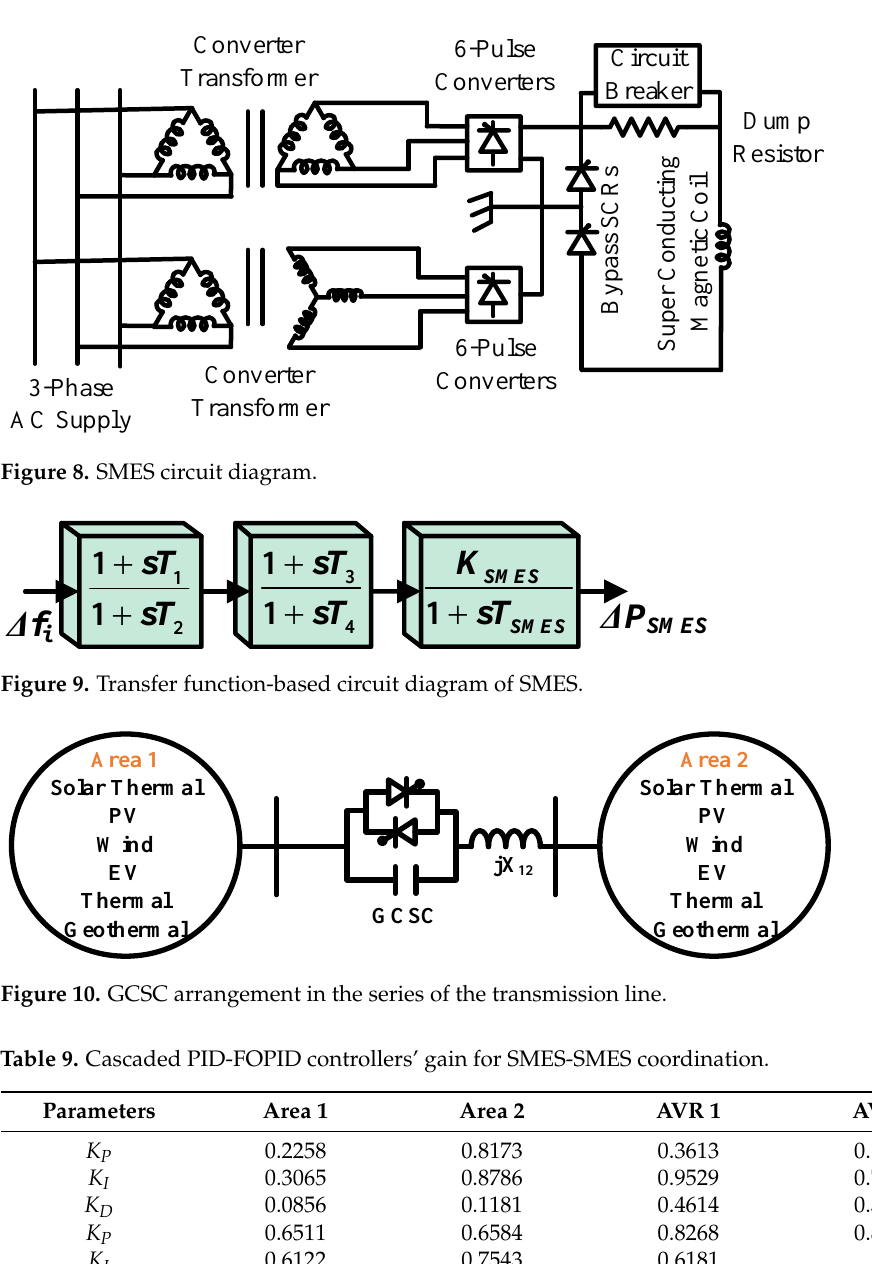
Figure 9. Transfer function-based circuit diagram of SMES. Figure 10. GCSC arrangement in the series of the transmission line.